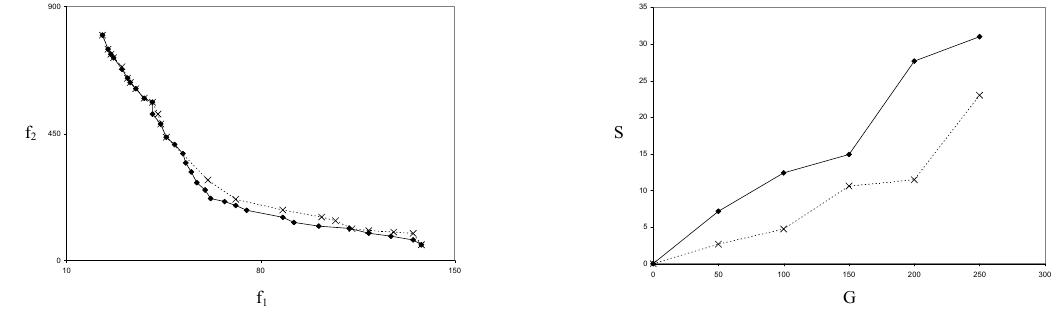
Fig. 7. f 1 vs. f 2 (Left) and G vs. S (Right) for MOHEA ( ) and MOEA ( ) (MF05)